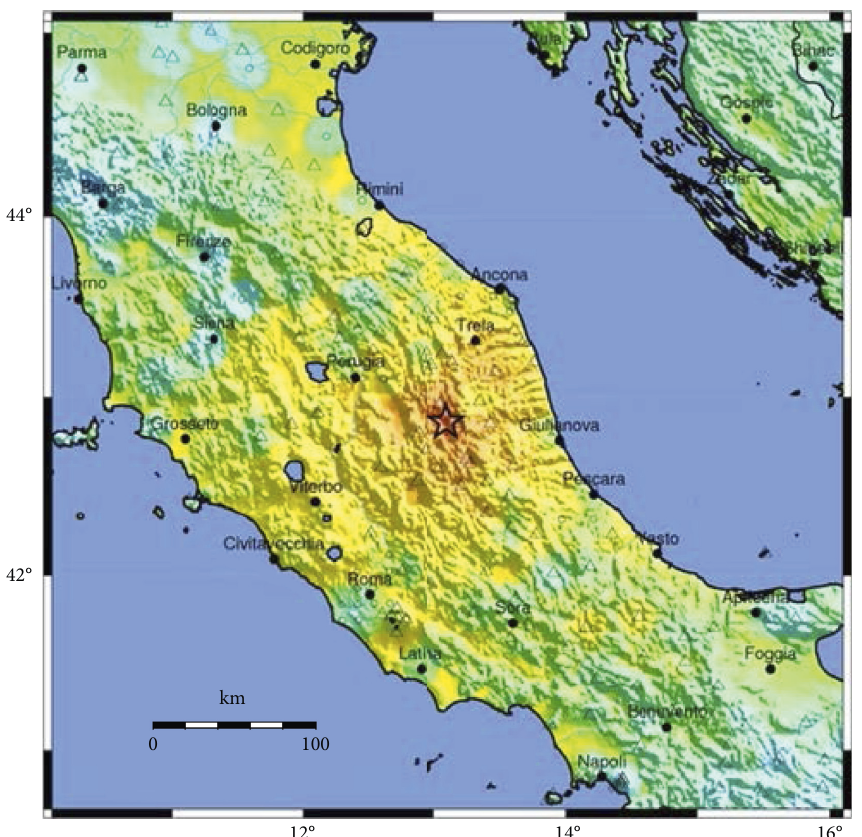
Figure 3: ShakeMap, northern Norcia Italy earthquake of 30 Oct 2016 [13].